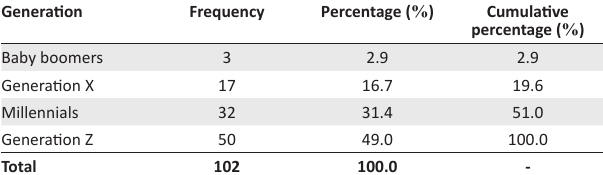
TABLE 3: Generational codes.